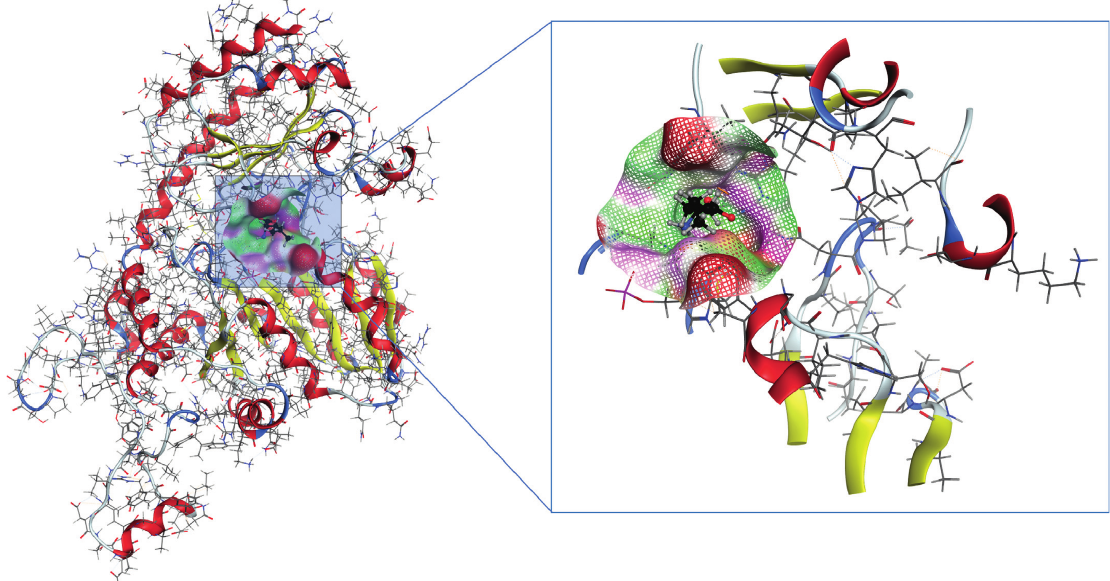
Figure 2: The 3D structure of L-methionine c -lyase enzyme and the chosen active site for C. freundii (PDB: 3JWB).